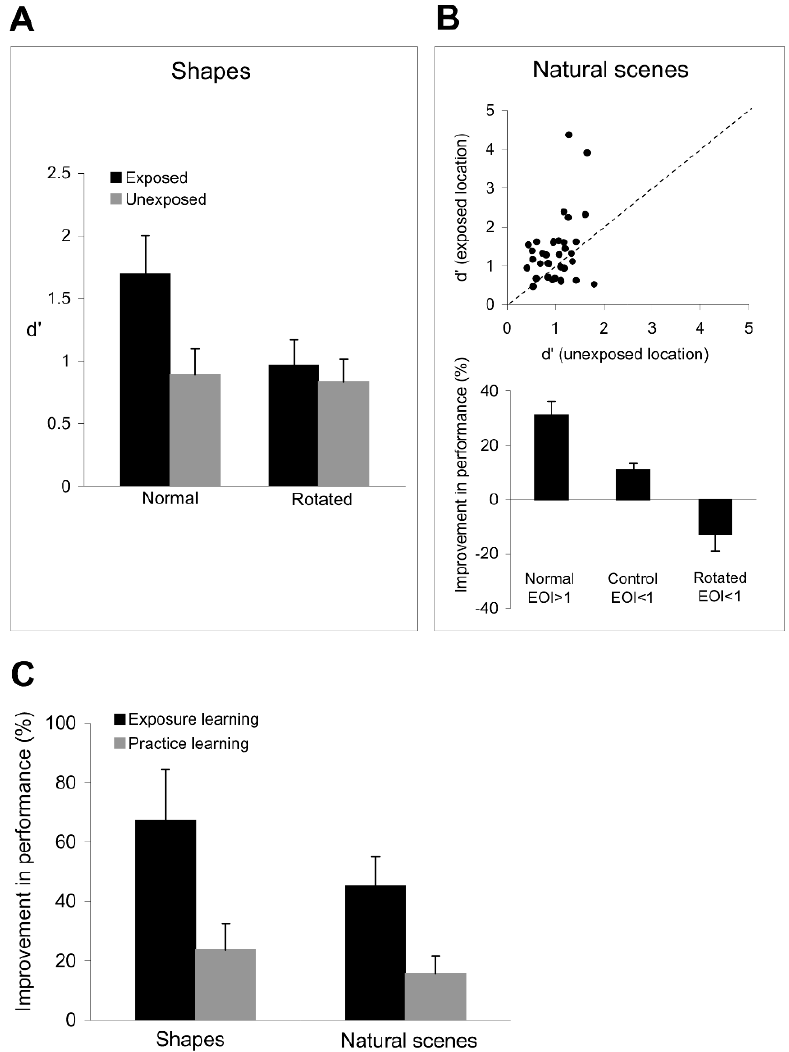
Figure 8. Results of the stimulus generalization experiments. ( A ) Shape discrimination performance is improved after exposure to orthogonal orientation sequences. In the ‘normal’ condition, i.e., shapes were not rotated, there is a significant improvement in shape discrimination performance only at the exposed location (black bars), whereas there is no improvement in performance at the unexposed location (grey bars). In the ‘rotated’ condition, we rotated the target and test polygons by 20°, in which case the improvement in shape discrimination performance at the exposed location was abolished. ( B ) Top: Image discrimination performance is improved after exposure to orthogonal orientation sequences. The scatter plot represents the discrimination performance at the exposed location vs. that at the unexposed location. Each point represents the d’ value for one subject and one image (averaged across 3 sessions). Only images with an exposure orientation index greater than 1 were included in the analysis. Bottom: Exposure to orthogonal orientations does not improve the discrimination of images with weak orientation signals along exposed axes (EOI < 1) and the discrimination of images that were rotated by 20°. We rotated only the images that had strong orientation signals along the exposed axes (EOI > 1 before rotation). ( C ) Mean improvement in shape and image discrimination performance at the exposed and trained locations (relative to the unexposed and untrained locations). Subjects exhibited a larger mean improvement in shape and image discrimination performance after exposure learning (black bars) than after practice learning (grey bars). The improvement in discrimination performance was compared in 4 sessions at the exposed and trained locations in each subject. Error bars represent SEM.